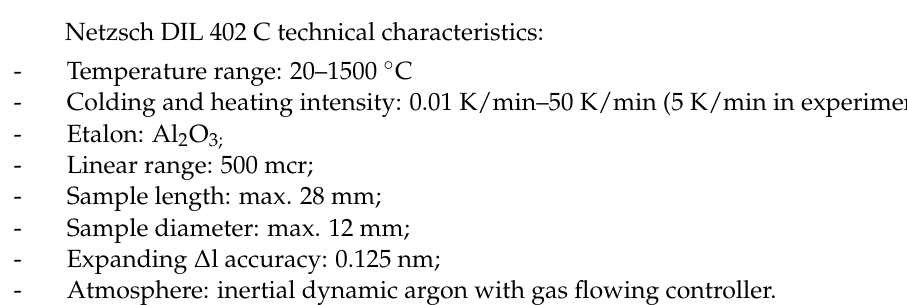
Figure 1. Examples of polymer and GRP samples.